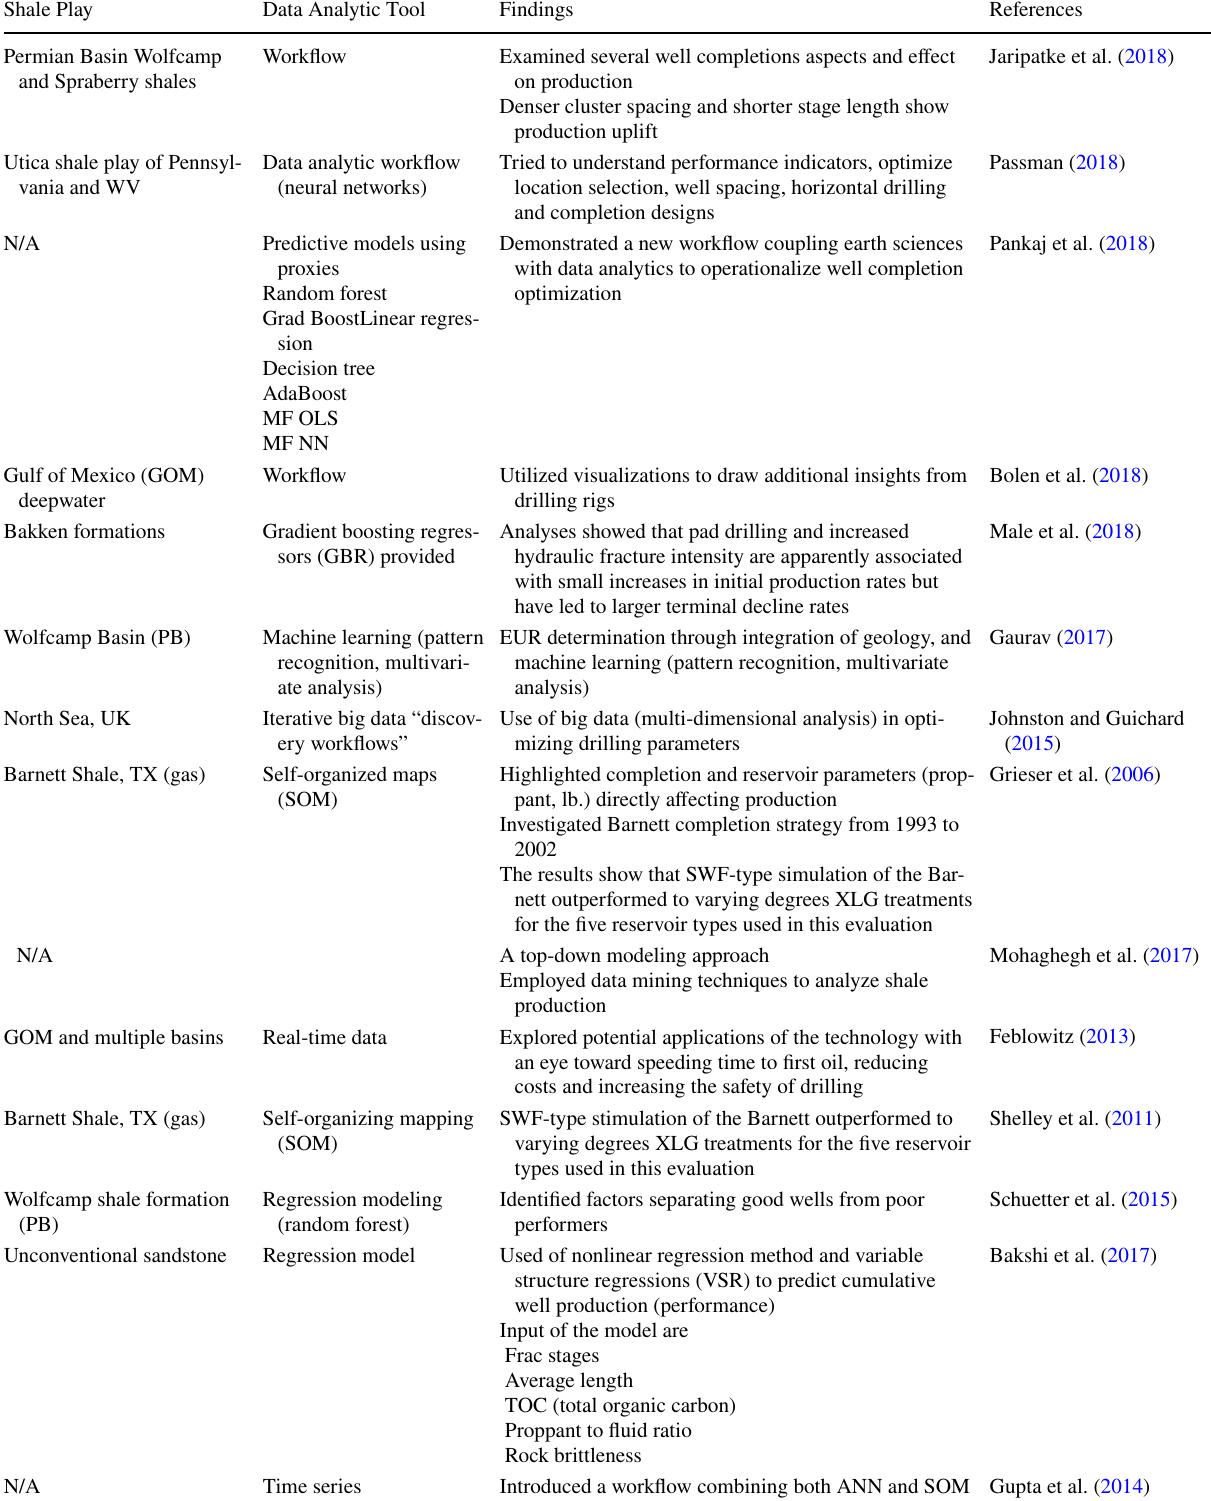
Table 6 Data analytics tools used for unconventional reservoirs Shale